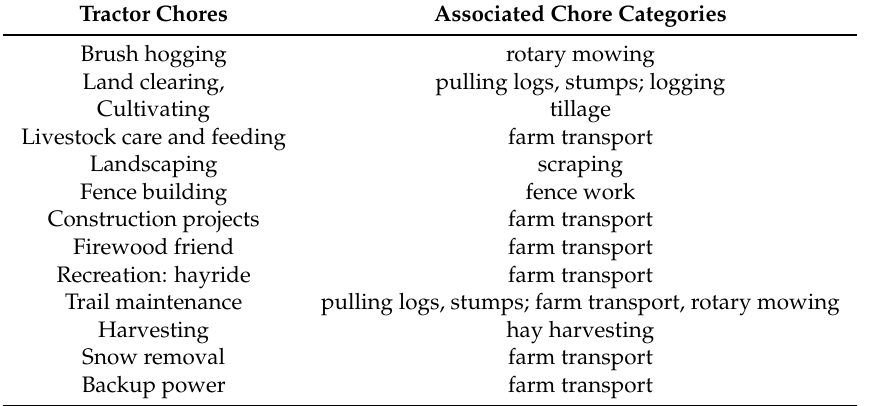
Table 1. Tractor chores listed in 2016 and associated chore categories used later in this article. Tractor